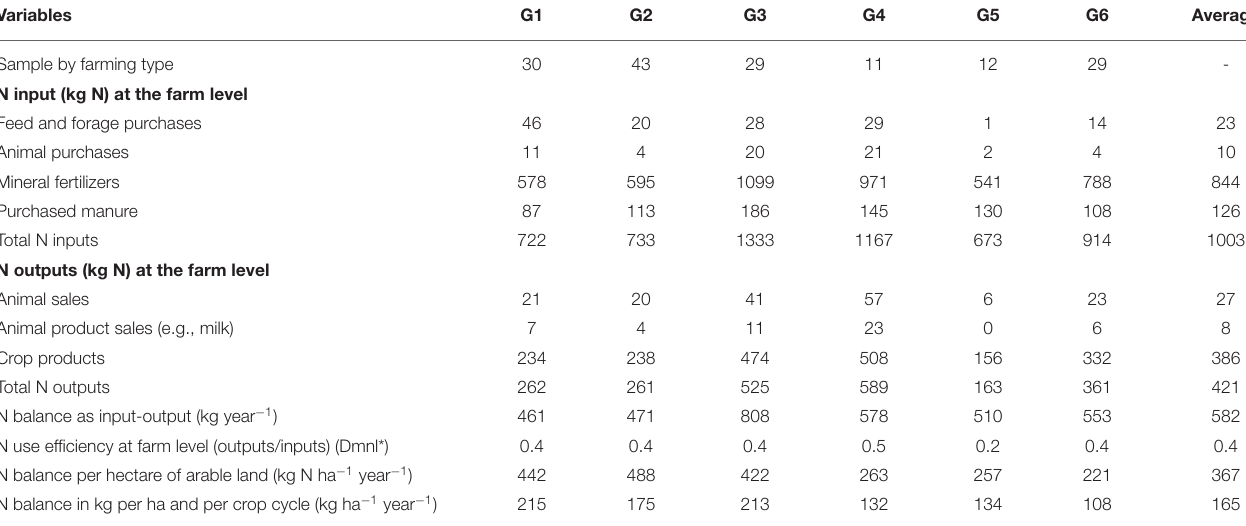
TABLE 4 | Nitrogen (N) flows, N balance, and N use efficiency at the farm level (154 farms), without inputs from leased grazing.